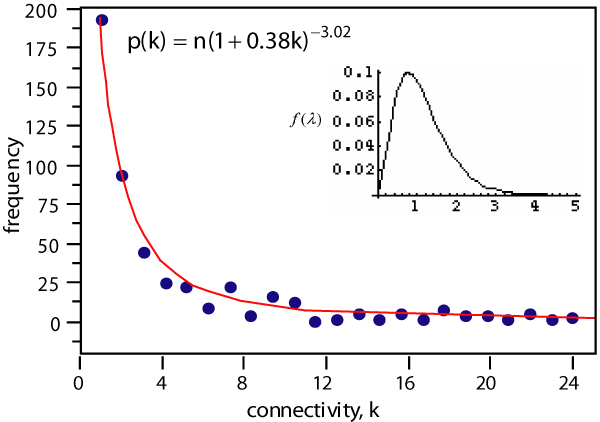
The variable rate of attachment model. Fit of the variable rate of attachment model (see text) fitted to the overall connectivity distribution of Figure 3 (right panel), accounting for 99% of the variance and illustrating that power-law scaling can emerge if proteins have different fixed propensities for forming attachments. Inset shows the predicted frequency distribution of attachment rates (α = 0.38, β = 3.02) under the variable rate of attachment model: most genes cluster around a low rate of attachment but a few show high rates of attachment, producing the 'hub' nodes in the network.